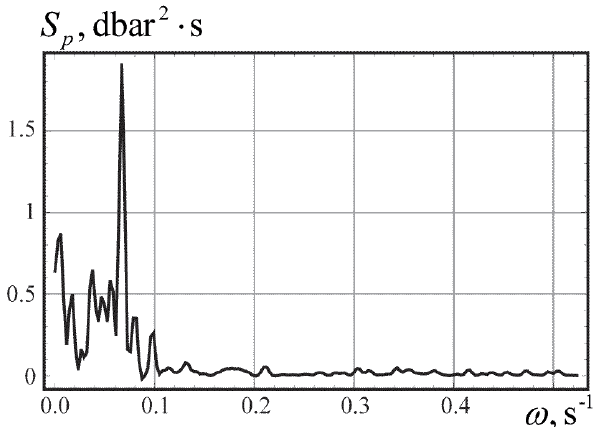
Fig. 5. Spectrum of the pressure gauge record at the bottom during the time interval of the tsunami event. The main peak corresponds to 93s.